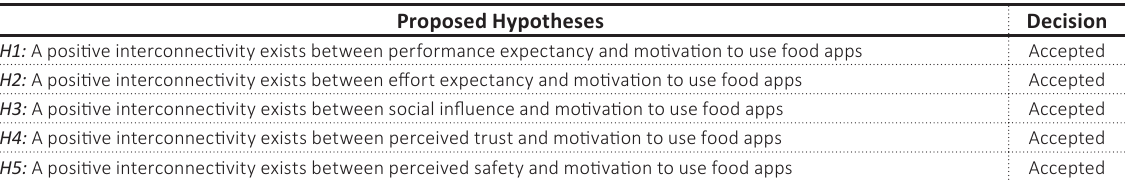
Table 4. Summary of hypotheses